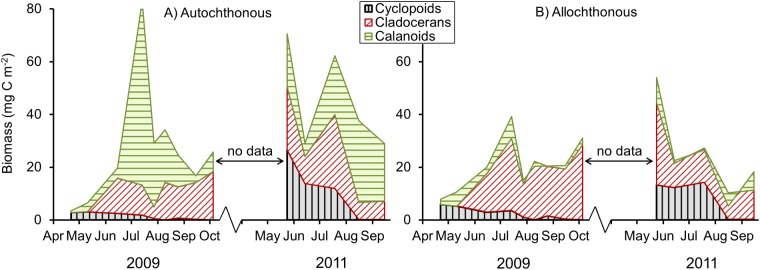
Stacked zooplankton biomasses measured at the center of lake Övre Björntjärn.The biomass for all organisms is divided into (A) an autochthonous part and (B) an allochthonous part, based on a calculation using stable hydrogen isotope data (Fig. 1b) together with an algebraic mixing model as described in the text.